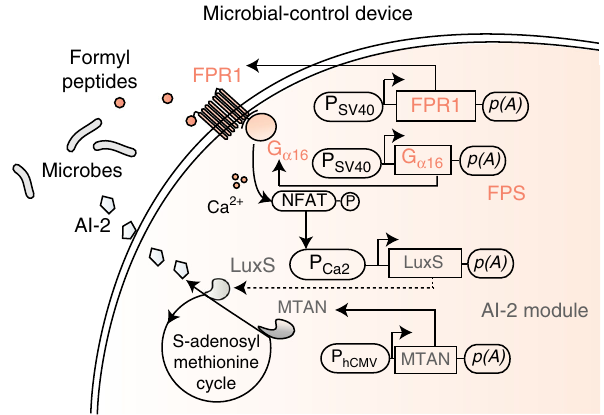
Fig. 1 Design of the cross-kingdom microbial-control device. A synthetic gene network constantly monitors the presence of pathogen-derived formyl peptides and programs the corresponding production of autoinducer-2 (AI-2) by human HEK-293 cells. In particular, (i) N-formyl peptides activate the sensor module consisting of ectopically expressed human formyl peptide receptor 1 (FPR1; P SV40 -FPR1-pA, pFS98) rewired to the constitutively expressed promiscuous human G protein subunit G α 16 (P SV40 -G α 16 -pA, pFS102) and relays to calcium-triggered expression of S-ribosylhomocysteinase (LuxS; P Ca2 -luxS-pA, pFS186). (ii) The ectopically expressed methylthioadenosine nucleosidase (MTAN, P hCMV -MTAN-pA, pFS84) supplies the terminal AI-2 catalytic component